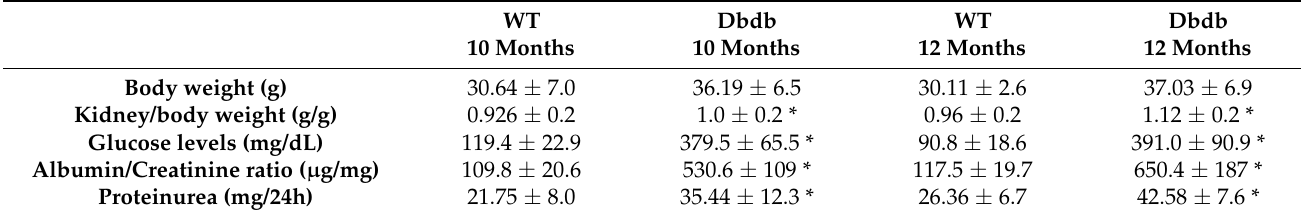
Table 1. Physiological parameters of wild-type (WT) and diabetic mice (db/db) at 10 and 12 months old. Blood glucose level is much higher in diabetic mice than in WT mice, as expected. Both body weight and kidney/body weight ratio are higher in diabetic mice than in WT mice. Albumin/Creatinine ratio is higher in diabetic mice compared with WT mice. Diabetic mice have more proteinuria compared with WT mice at both 10- and 12-months-old. A significant difference from WT mice is indicated by * p <